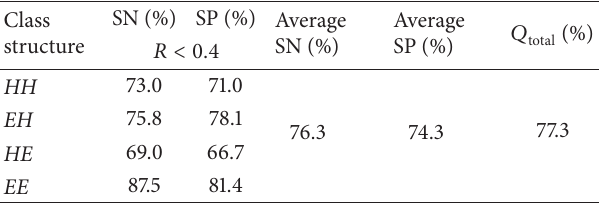
Table 1: The predicted accuracies by using six CSs as features (3-fold